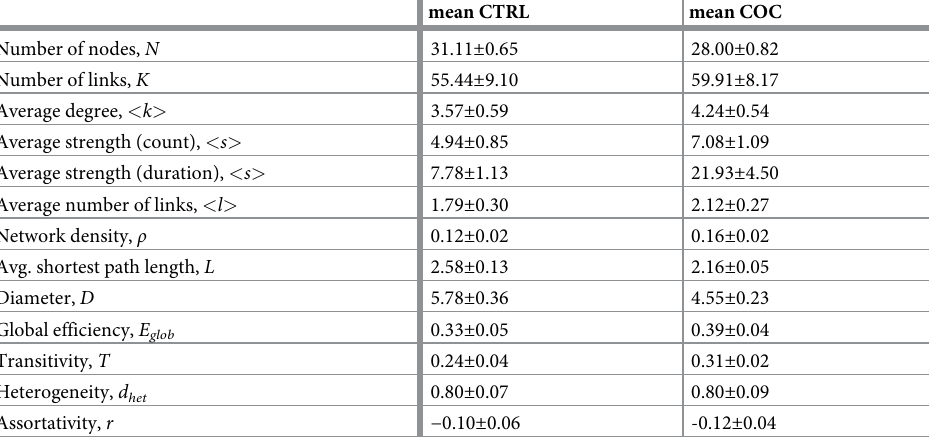
Table 1. Global level network-based measures. Table represent values calculated at the global level of network for control (CTRL) and cocaine (COC) populations. Usage of specific edge weight (count, duration) in the calculation of measure is indicated in brackets next to the name of the